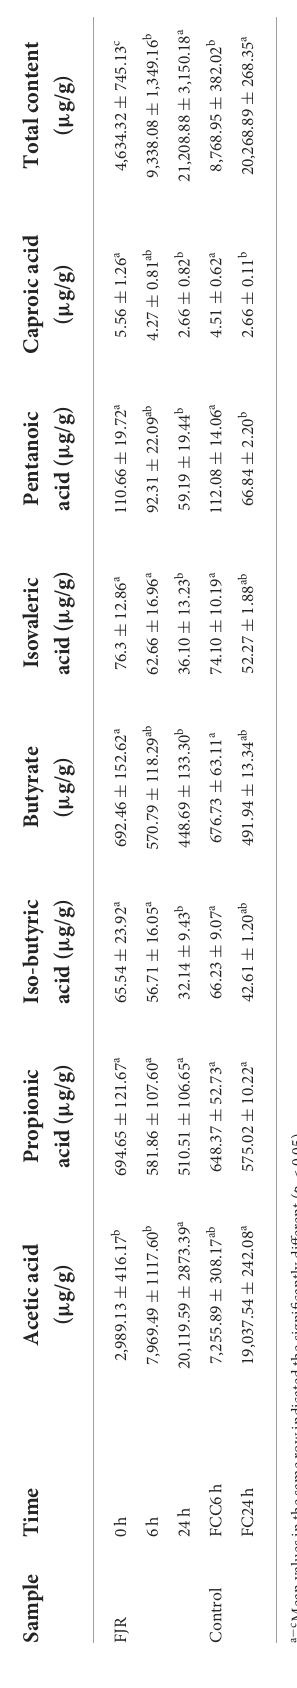
community richness. For OTUs analysis, there were 483, 327, 297, 273, and 228 OTUs for the F0 h, FC6h, F6h, F24 h,